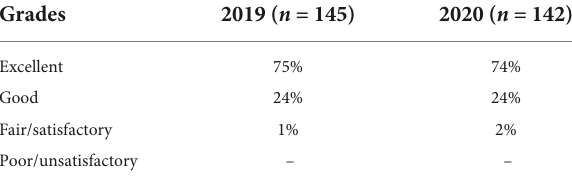
TABLE 2 Final exam results at bachelor level.